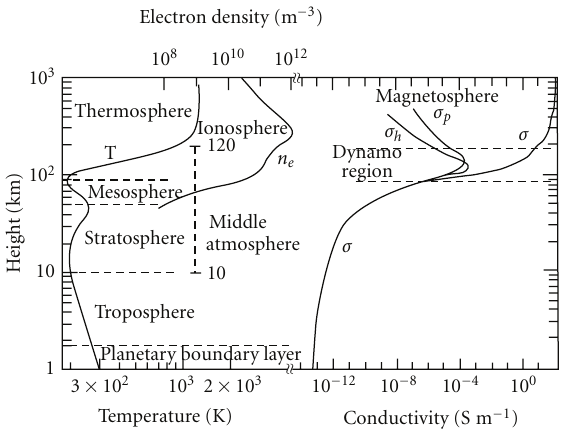
Figure 1: Variation of temperature, electron density and electrical conductivity of various atmospheric layers, after